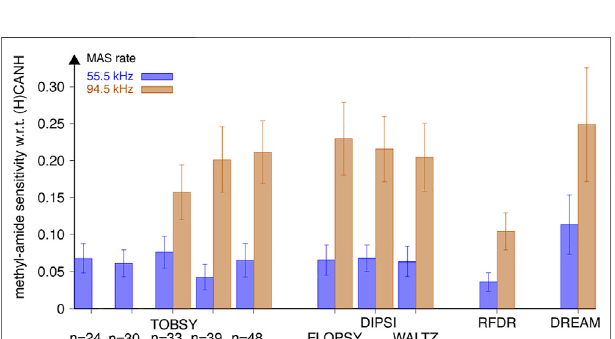
FIGURE9| Sensitivity(S/Nperunittime)ofmethyl-to-amidecorrelations in 3D (H)C(CC)(CA)NH spectra normalized to sensitivity of respective intraresiduecorrelationsin3D(H)CANHspectra,recordedforSH3proteinata MAS frequency of 55.5 ( blue bars, left in each pair) and 94.5 kHz ( tan bars, right in each pair) on an 18.8-T spectrometer using various 13 C mixing schemes. Relative intensity of 24 cross-peaks [for 6 valine (all except Val-46), 1 isoleucine, and 6 leucine residues] was averaged with equal weights. Data for TOBSY C9 1 24 and C9 1 30 were not collected at ν R = 94.5 kHz. The error bars re fl ectthestandarddeviation(scatter)ofvaluesobservedforasetofresidues, not the experimental error of average sensitivity.